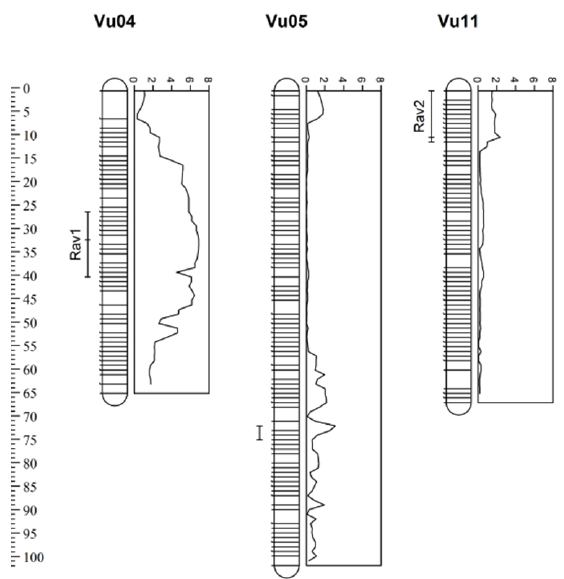
Figure 2. Cowpea linkage groups and Alectra vogelii resistance quantitative trait loci (QTL) with logarithm of the odds (LOD) scores. Significant QTL, Rav1 and Rav2 , were identified by categorical trait multiple interval mapping (CT-MIM). Error bars indicate a 1-LOD confidence interval and scale is provided in centiMorgans (cM). Table 4. Segregation of SNP markers associated with Alectra vogelii resistance in susceptible class F 2